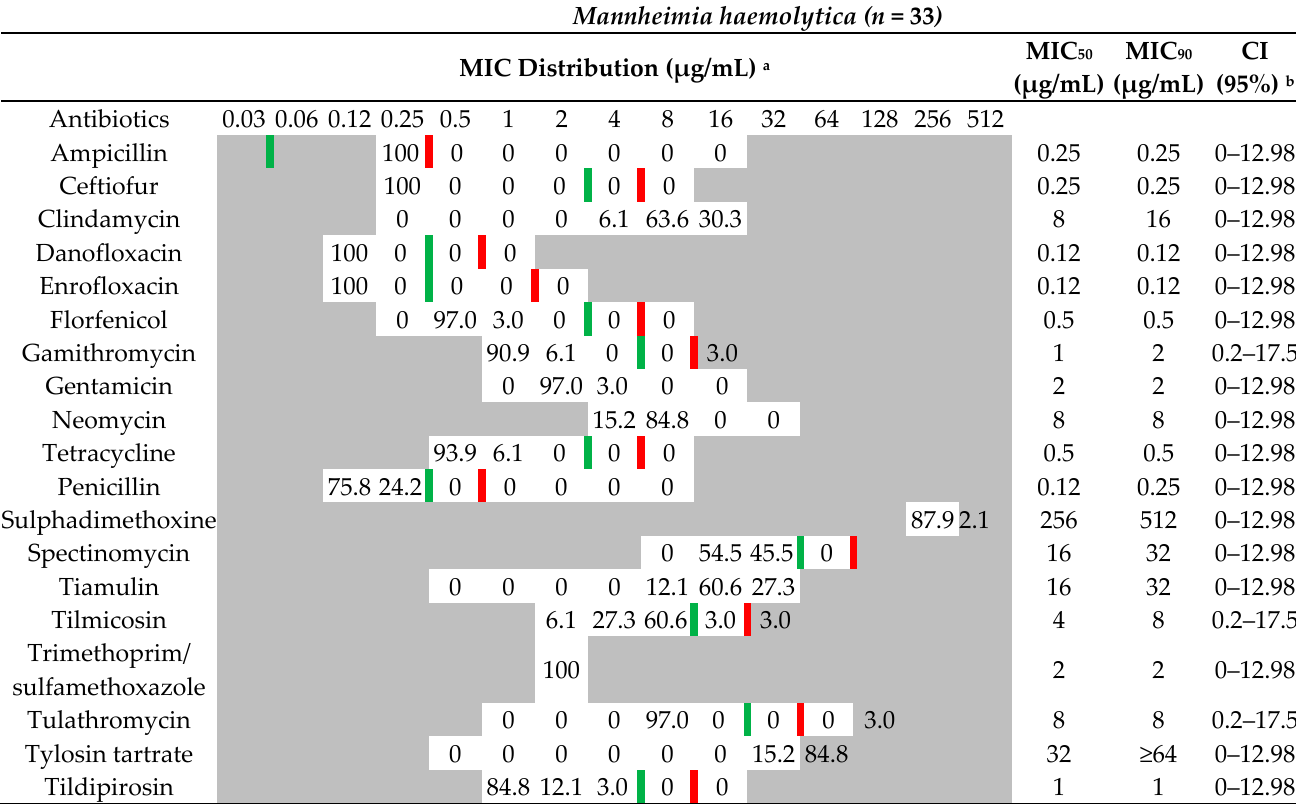
Table 4. MIC distribution frequencies of M. haemolytica cattle isolates from Australia 2019.